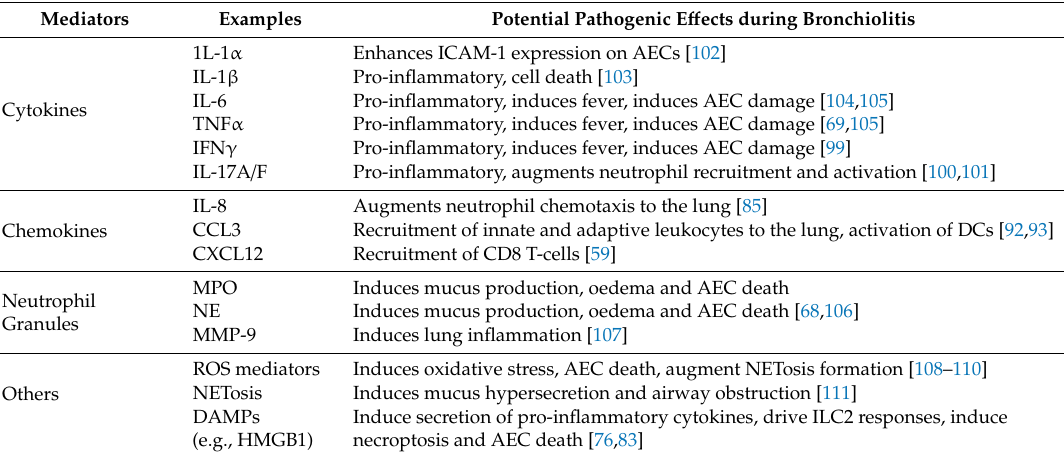
Table 2. Neutrophil inflammatory mediators released in response to RSV infection. AECs, airway epithelial cells; DAMPs, danger-associated molecular patterns; DCs, dendritic